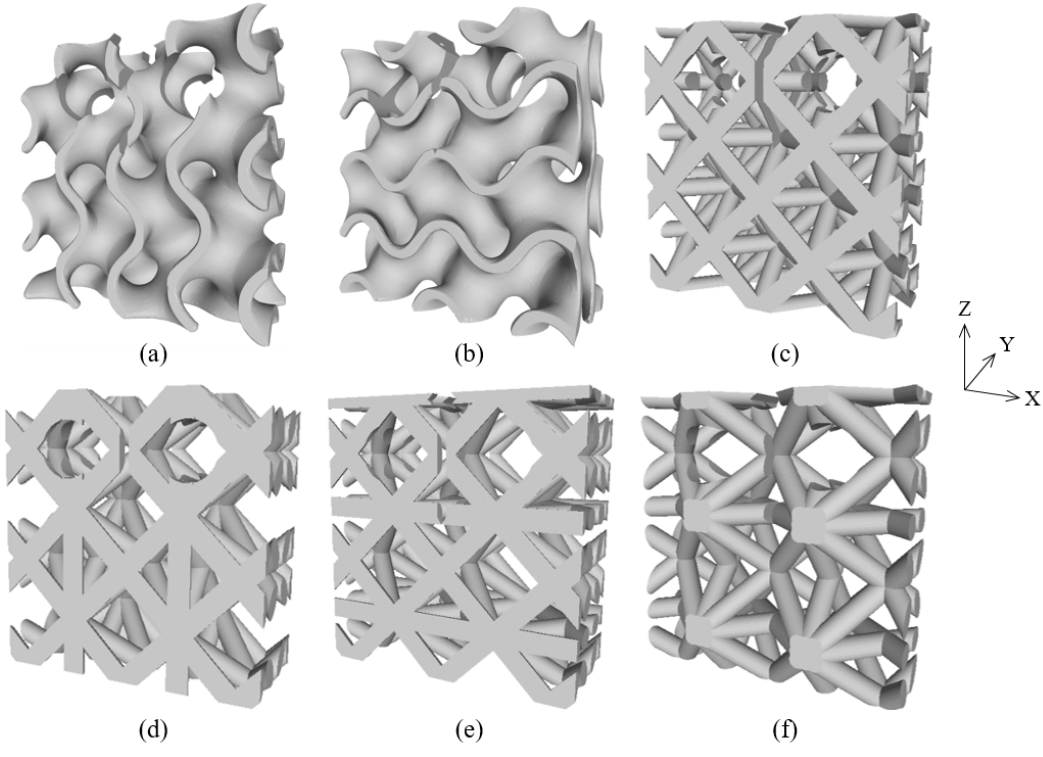
Figure 4. Topological inserts cut according to a CT specimen—Z-orientation gyroid (Gyroid_01) ( a ), X-orientation gyroid (Gyroid_02) ( b ), octet-truss ( c ), Z-orientation FBCCZ (FBCCZ_01) ( d ), X-orientation FBCCZ (FBCCZ_02) ( e ) and Y-orientation FBCCZ (FBCCZ_03) ( f ).